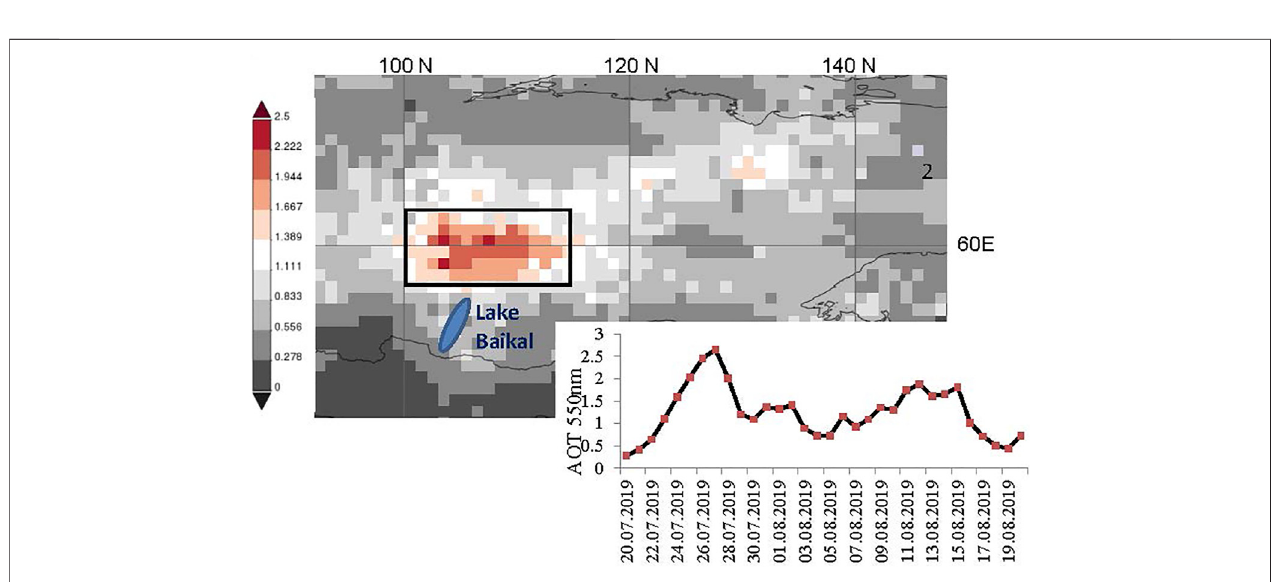
FIGURE 9 | Monthly mean AOT (MODIS, 550 nm, July 20 – August 20, 2019) resulting from intense Siberian wild fi res north and northeast of Lake Baikal (indicated by a blue oval symbol) and time series of daily mean smoke AOT for the indicated rectangular box. The fi gure is taken from Ohneiser et al. (2021).